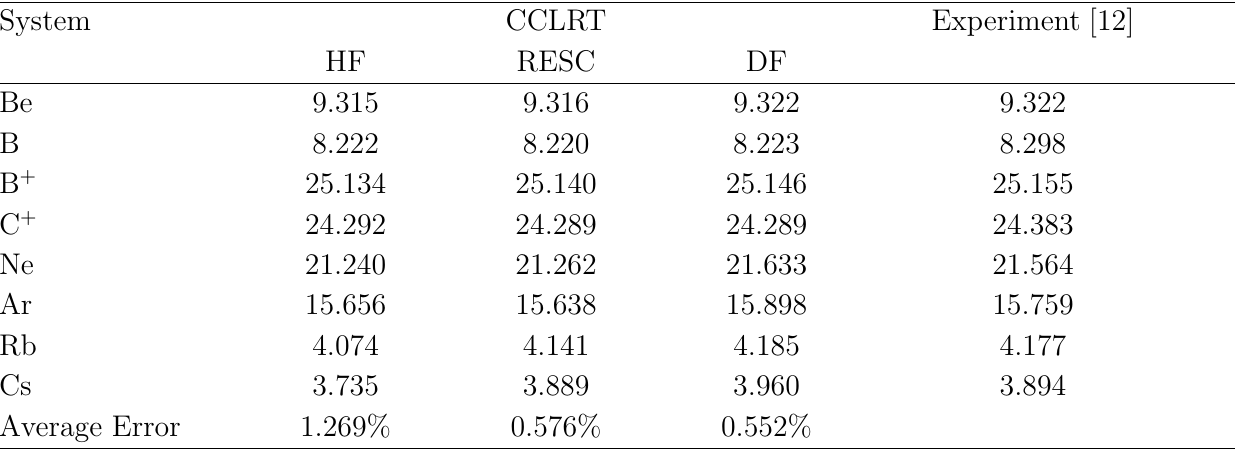
Table 2: Ionization Potentials (in eV) of Be, B, C ++ , Ne, Ar, Rb, and Cs obtained from